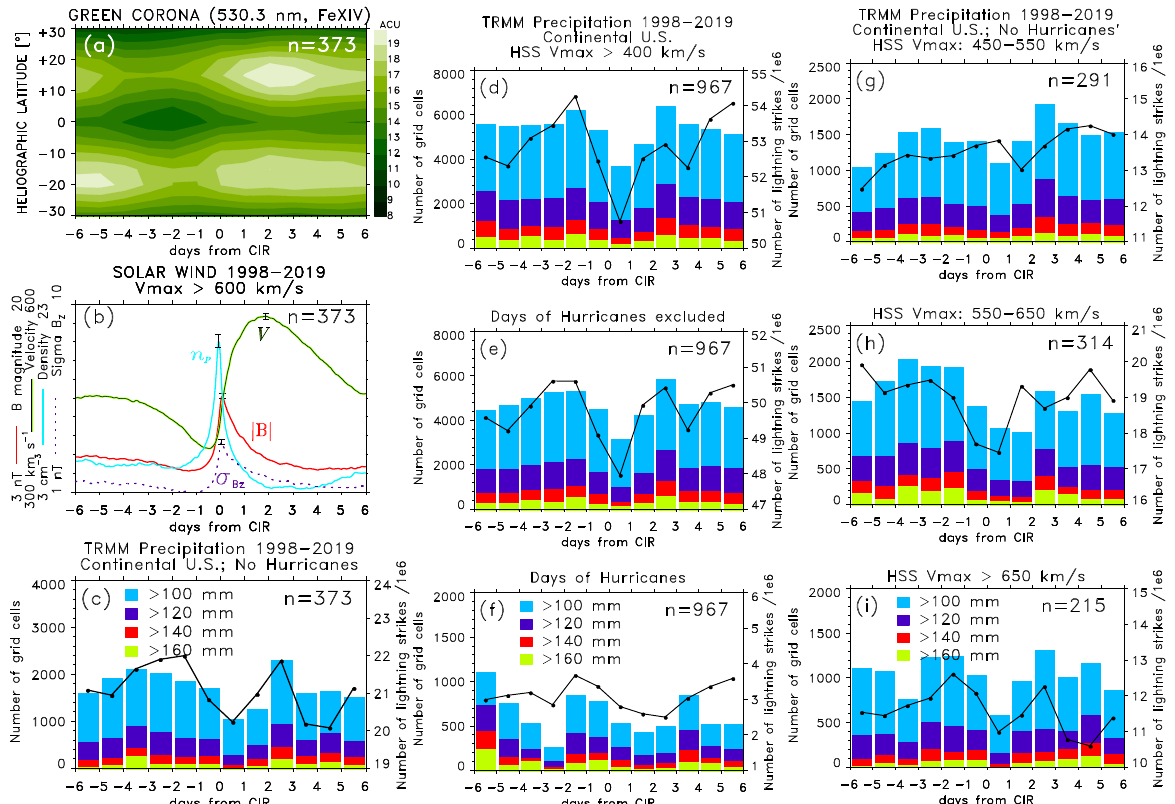
Figure 6. The SPE analysis of time series of ( a ) green corona intensity and ( b ) solar wind plasma variables keyed to arrivals of HSS/CIRs for solar wind streams that reached maximum velocity V max > 600 km/s. ( c ) The cumulative number of TRMM grid cells over continental U.S. with above-threshold daily precipitation rates and days of hurricane impacts excluded. The SPE analysis repeated for V max > 400 km/s with hurricanes ( d ) included, ( e ) excluded, and ( f ) limited to days of hurricanes only, and ( g – i ) for three ranges of V max with cyclone days excluded. The cumulative numbers of lightning strikes over the CONUS region are shown with dots and black solid line.